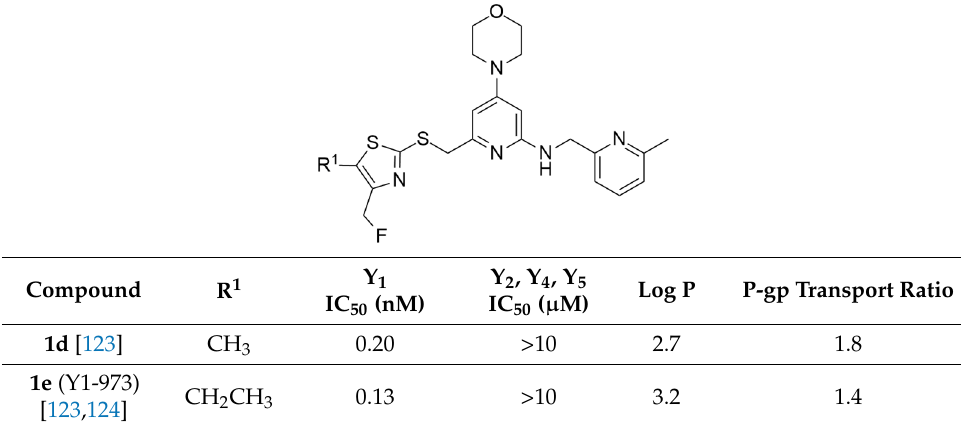
Table 4. Structure and in vitro properties of compound 1d and 1e (Y1-973).